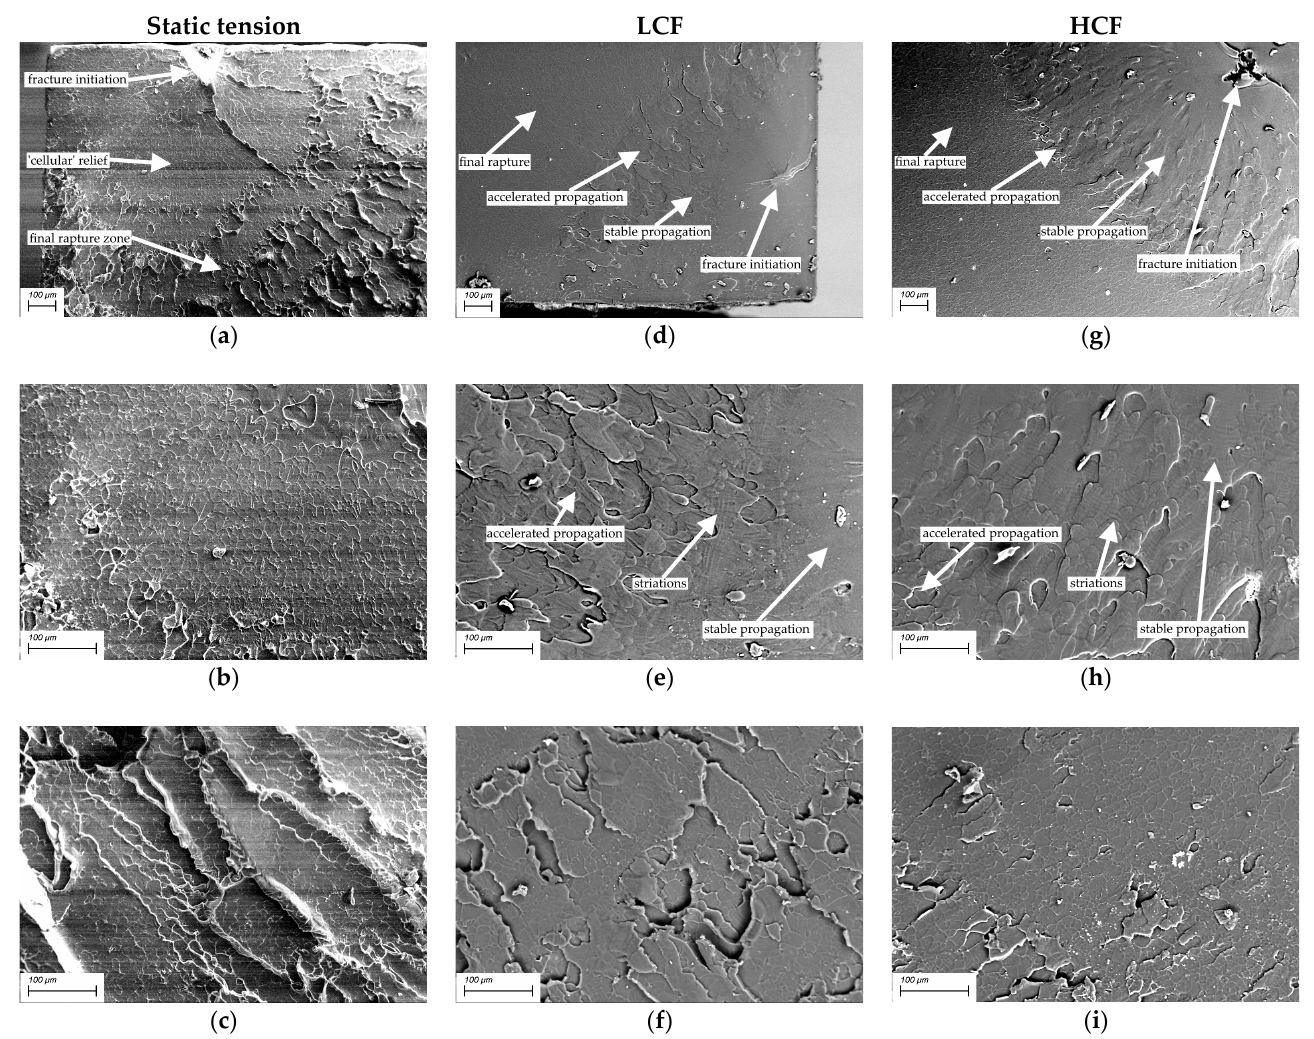
Figure 8. The SEM micrographs of the neat PI fracture surfaces: left column—under static tension, middle column—under LCF, right column—under HCF: ( a ) fracture initiation region, ( b ) “cellular” relief pattern, ( c ) final rupture zone, ( d ) fracture initiation region, ( e ) transition from stable crack propagation zone to its accelerated propagation one, ( f ) final rupture zone, ( g ) fracture initiation region, ( h ) transition from accelerated crack propagation zone to its final rupture one, ( i ) final rupture zone.